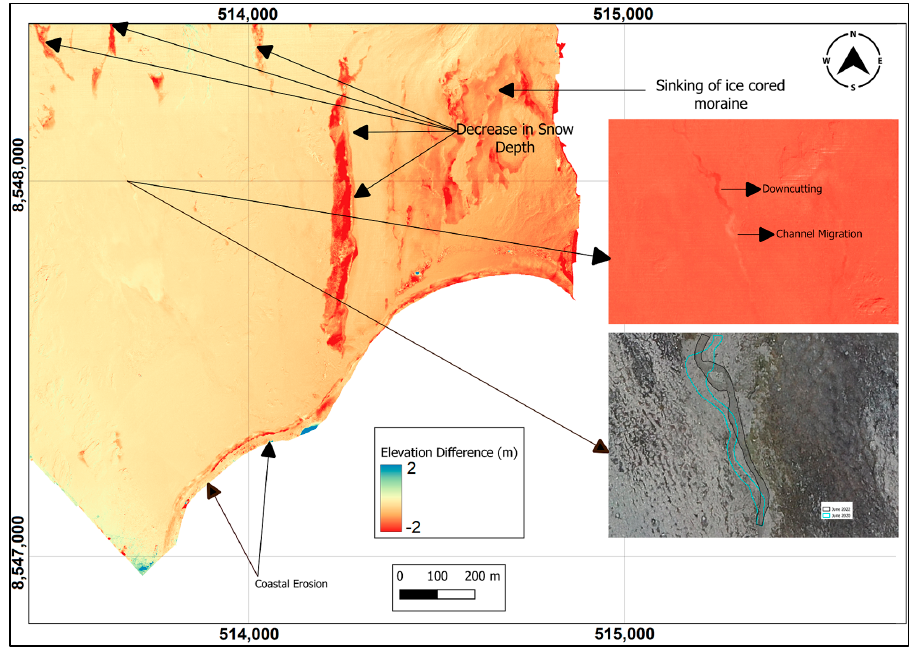
Figure 14. Estimated differences in elevation between drone DEM from 2022 and SIOS DEM from 2020 in the Fuglebekken catchment. Detected changes include a decrease in snow thickness, the sinking of an ice-cored moraine, river channel migration, and coastal erosion.